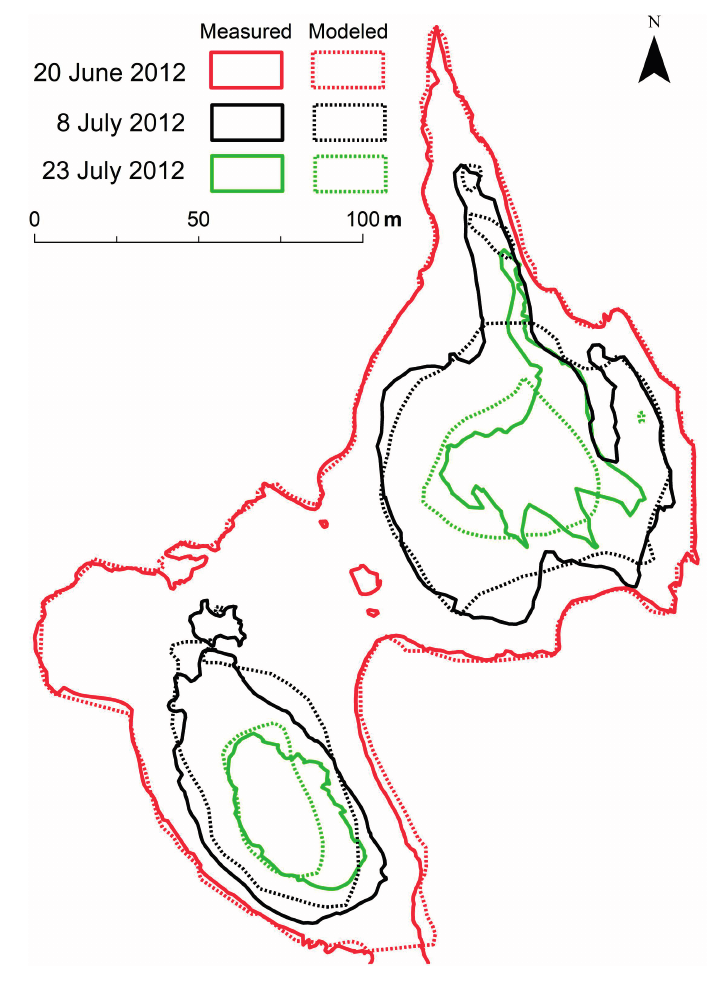
Figure 5. Comparison of the measured (solid line) and modeled (dashed line) extent of snow fields based on the temperature-index model between 20 June and 23 July 2012. The red outline corresponds to the date of the model